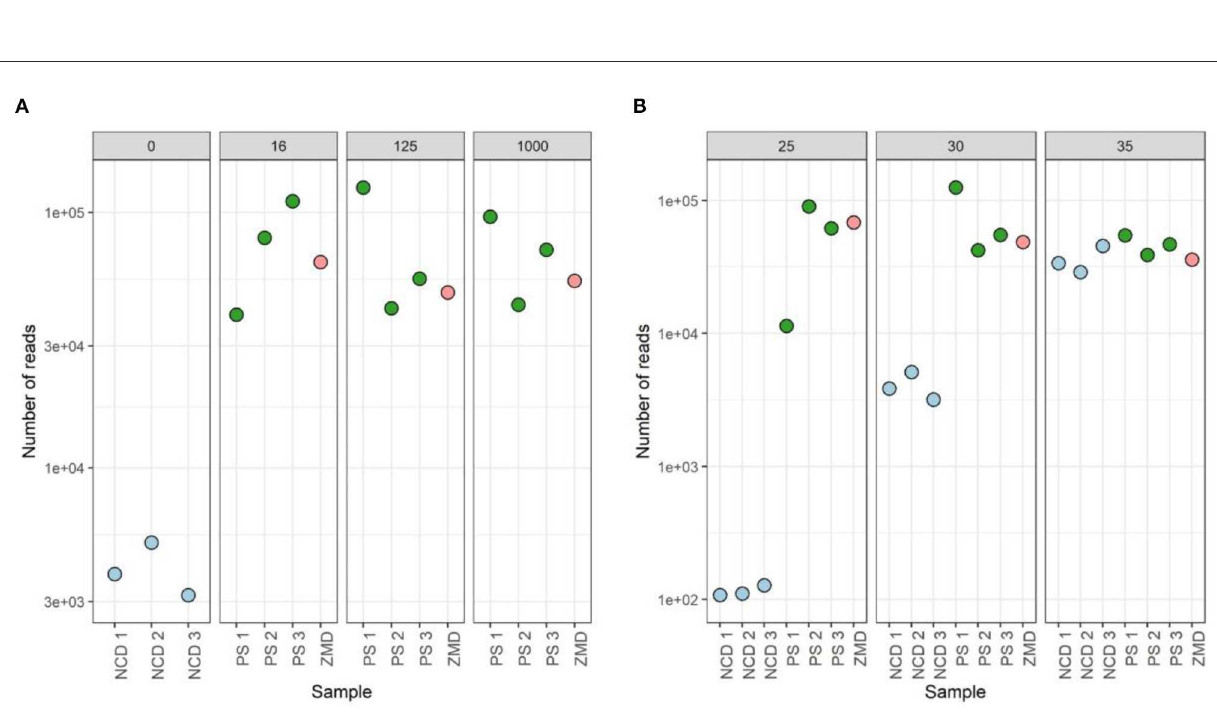
FIGURE10 Sequenced reads of three participant samples (PSs), three negative controls DNA (NCD), and one positive control, Zymo mock DNA (ZMD). The effect of different bacterial inputs (A) and PCR cycles (B) during the 16S rRNA gene V4 region PCR on the number of reads